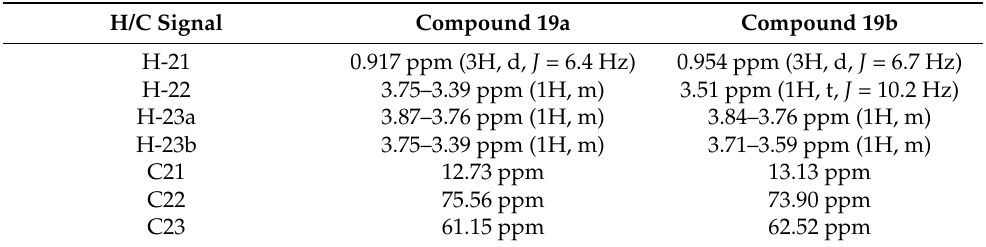
Table 3. Comparison between signals of 1 H- (500.1 MHz, CDCl 3 ) and 13 C- (125.8 MHz, CDCl 3 ) NMR for H/C21, H/C22, and H/C23a-b, for the epimers 19a and 19b